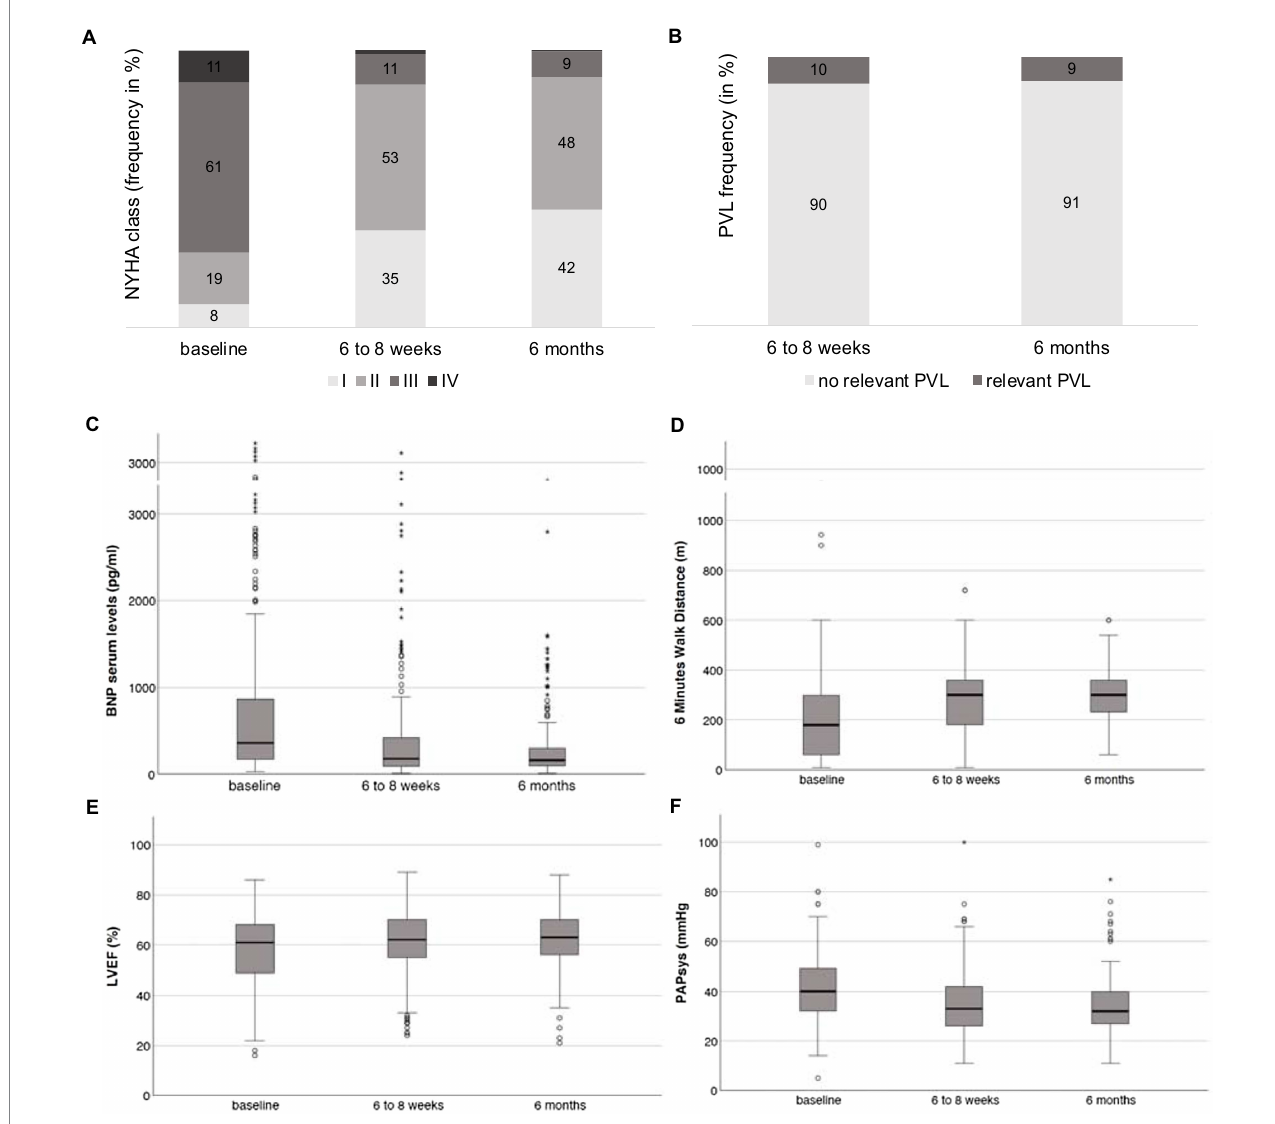
FIGURE 1 ( A ) Distribution of NYHA functional classes I to IV at baseline, the 6- to 8-week, and the 6-month follow-up. ( B ) Frequency of relevant PVL at the 6- to 8-week and the 6-month follow-up. Development of ( C ) BNP serum levels, ( D ) SMWD, ( E ) LVEF, and ( F ) PAPsys at baseline, the 6- to 8-week, and the 6-month follow-up.